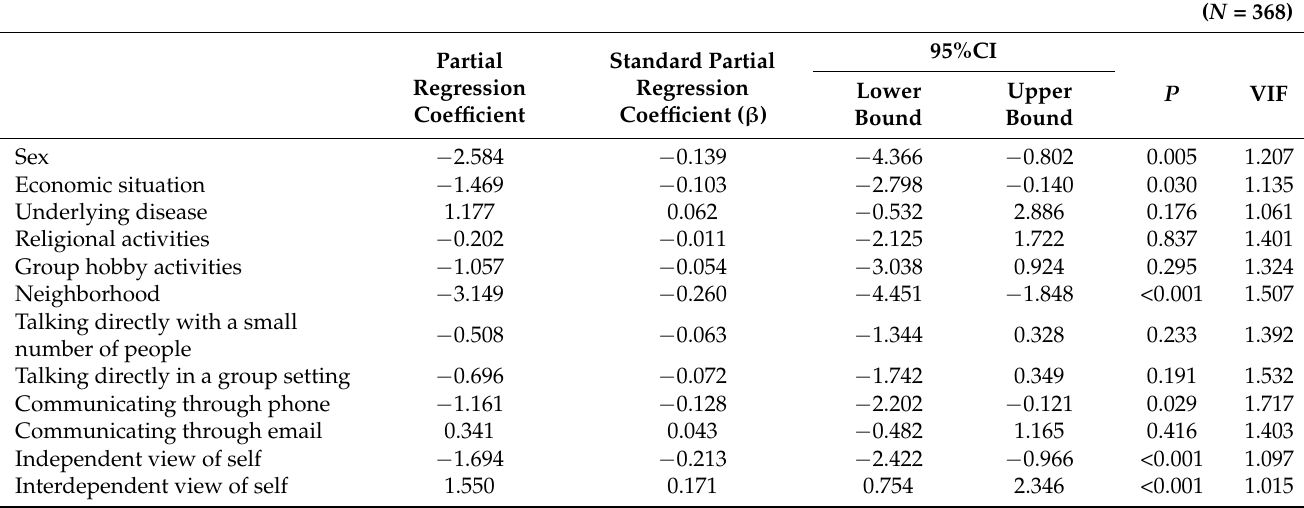
Table 3. Factors associated with loneliness in older adults during the COVID-19